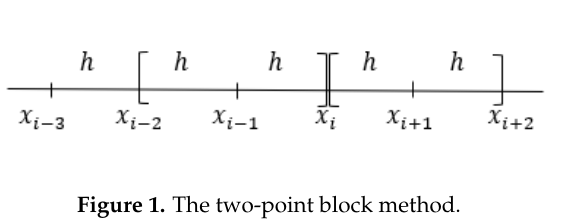
Figure 1. The two-point block